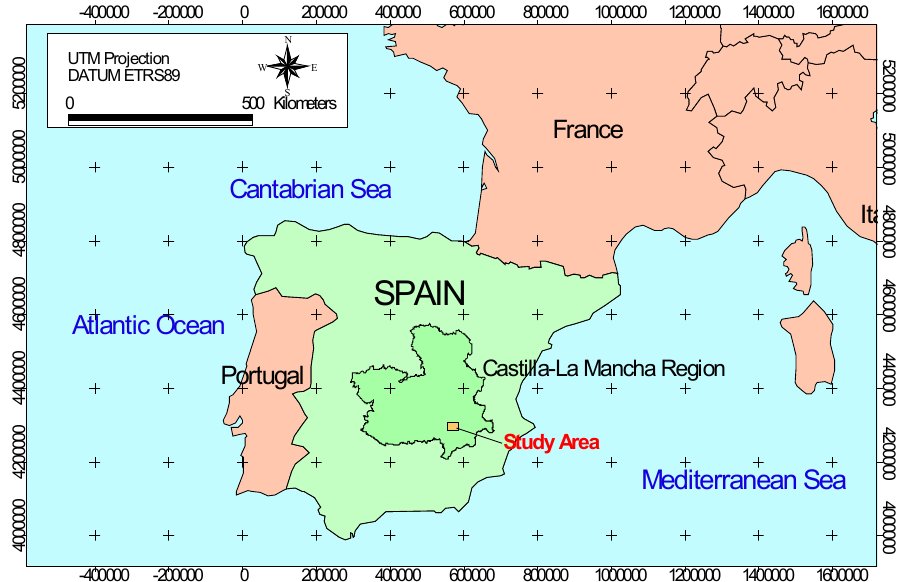
Figure 1. Study area: Castilla-La Mancha, a Spanish Mediterranean region with semi-arid climate in Southern Spain.